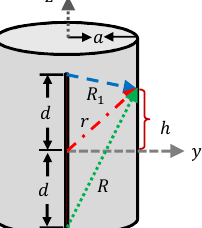
Figure 1: Geometry of a segment of a thin wire antenna for the Moment matrix